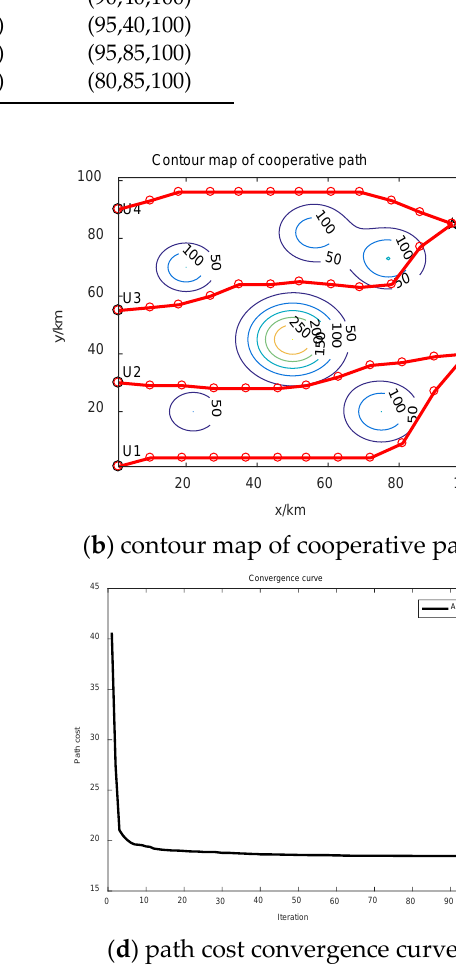
Figure 9. The result of case 2. ( a ) 3D UAV cooperative path map; ( b ) Contour map of cooperative path; ( c ) Convergence curve of each UAV; ( d ) Path cost convergence curve. Table 12. Range and flight time of each aircraft (case